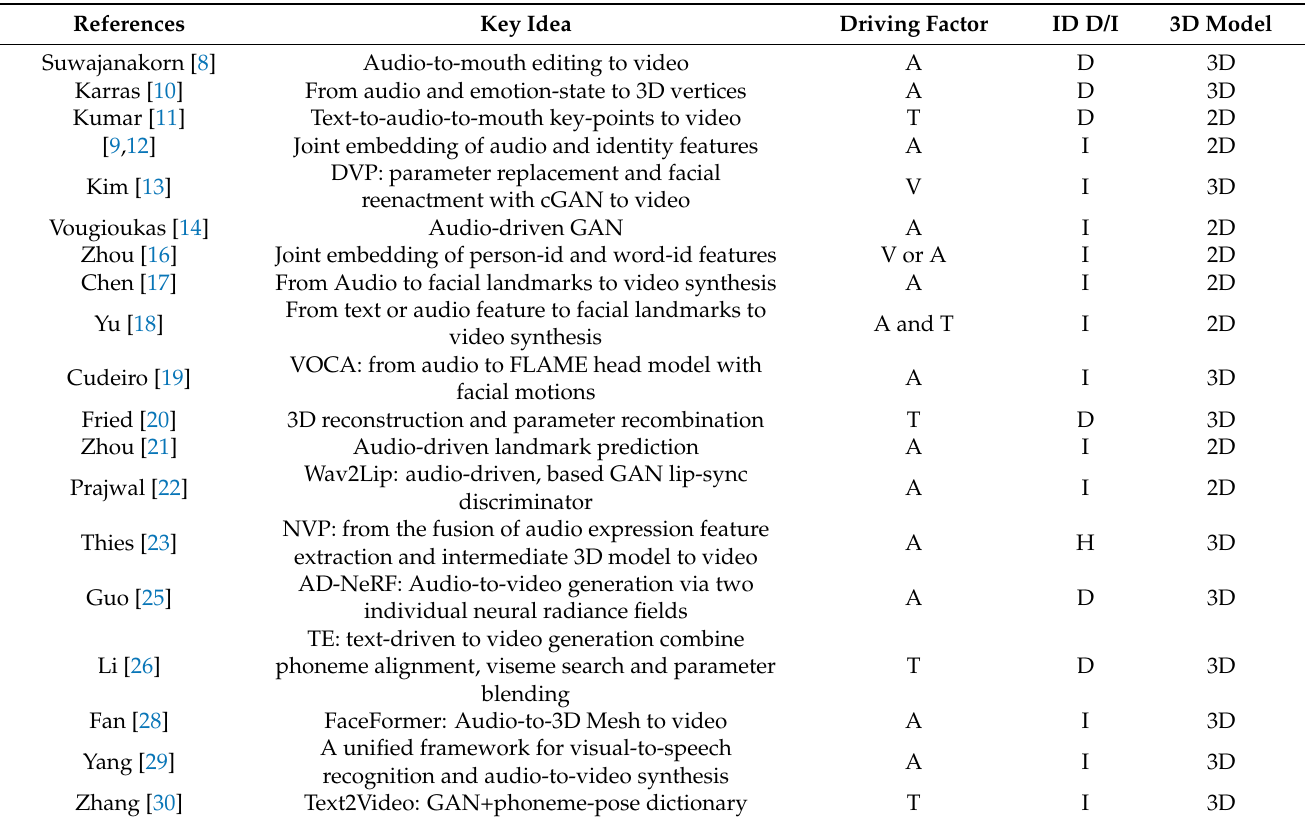
Table 1. The main model of talking-head generation in recent years. ID: The model can be divided into three types: identity-dependent (D), identity-independent(I), and hybrid(H). Driving Data: Audio(A), Text(T), and